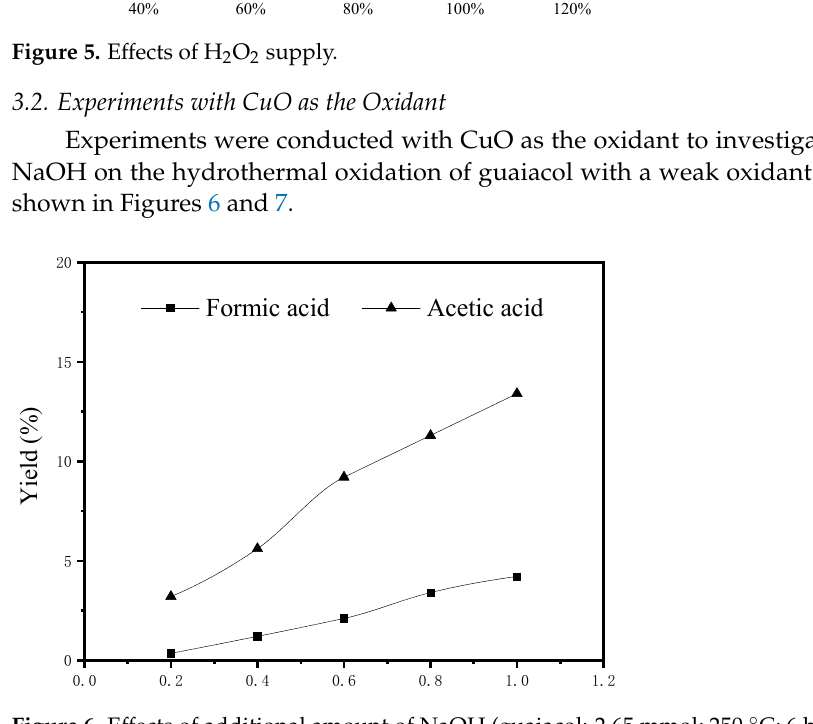
Figure 5. Effects of H 2 O 2 supply.